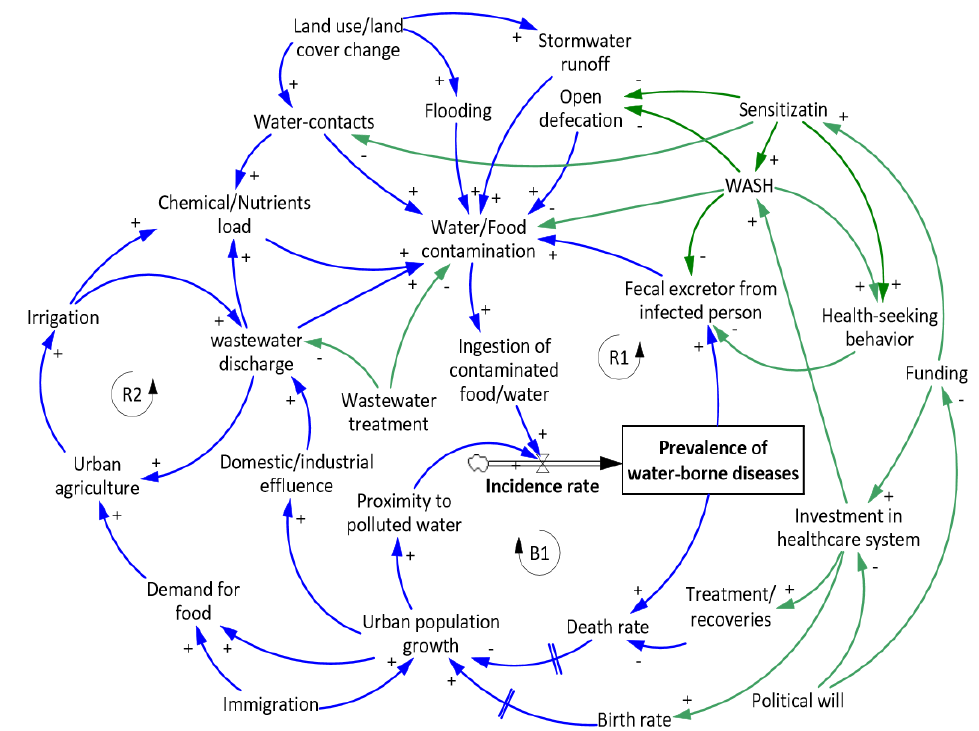
Figure 4. Water-borne diseases sub-model. The blue arrows show the connections between the variables, while the green arrows indicate the interventions altering the state of these variables. Data source: based on primary data collection in the Odaw River catchment in Ghana, in April 2019.